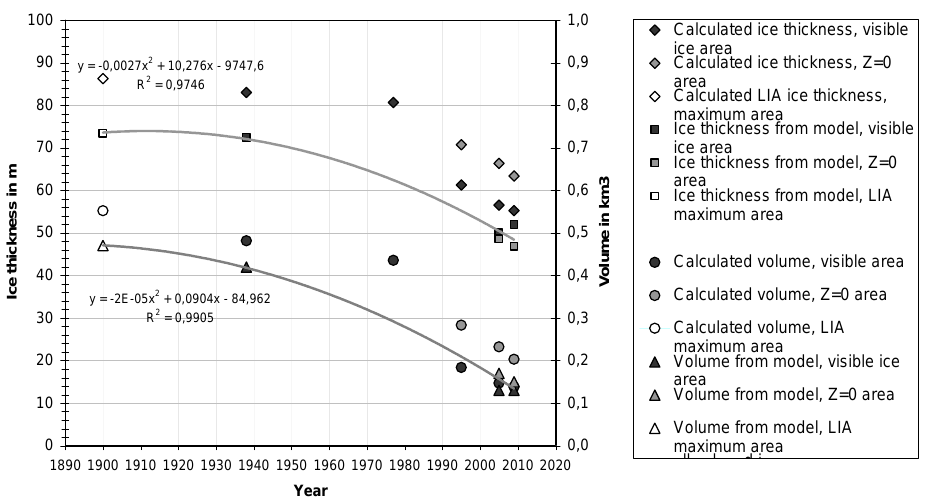
Fig. 4. Plot of mean ice thickness (upper curve) and volumes (lower curve) of Tellbreen as a function of time. The calculated volumes are derived from Eq. (1). The values can be found in Table 1.